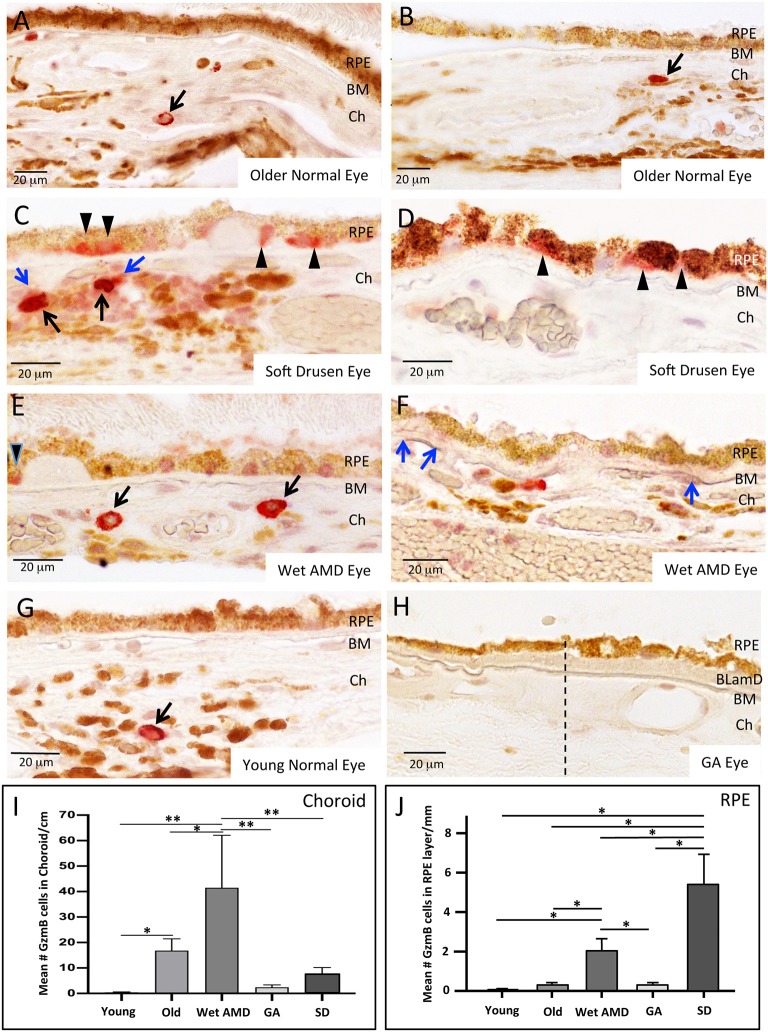
GzmB Immunoreactivity in normal and diseased human outer retina. (A,B) Examples of GzmB immunoreactivity in an older normal eye. Strong labeling with amino-ethyl carbazole chromogen (red) indicates GzmB+ cells in the choroid (black arrows). RPE cells in older normal eyes rarely displayed GzmB immunoreactivity. (C,D) Examples of GzmB immunoreactivity in eyes with soft drusen, an early marker of AMD. Strong labeling with amino-ethyl carbazole chromogen (red) indicates GzmB+ cells in the choroid (black arrows), with a cloud of extracellular GzmB immunolabeling surrounding the choroidal mast cells (blue arrows). The basal compartment of the RPE cell near soft drusen sites also contains GzmB immunoreactivity (black arrowheads). Note GzmB+ RPE appear of the “non-uniform” phenotype (27). (E,F) Examples of GzmB immunoreactivity in a wet AMD eye. Strong labeling with amino-ethyl carbazole chromogen (red) indicates GzmB+ cells in the choroid (black arrows). Extracellular GzmB immunolabeling is evident in the basal laminar deposit (blue arrows) of a wet AMD eye. In wet AMD eyes, fewer RPE cells contained GzmB compared to eyes with soft drusen, however, one is shown in (E) near a drusen site (black arrowhead). (G) An example of GzmB immunoreactivity in a younger normal eye demonstrating a single choroidal mast cell (arrow). RPE cells in younger normal eyes rarely displayed GzmB immunoreactivity. (H) GzmB immunoreactivity in a GA eye. Note lack of red chromogen product in choroid and in RPE. Dash line indicates a change in the morphology of the RPE monolayer, with “non-uniform” and “dissociated” RPE phenotypes to the right of the dashed line (27). Note thickened basal laminar deposit (BLamD) and deterioration of the choriocapillaris. Additional images of a GA eye are shown in Supplementary Figure 6. (I) Analysis of GzmB immunoreactivity of choroidal cells in older (>65 years, N = 8) and younger (<55 years N = 8) normal donor eyes, wet AMD (N = 6), GA (N = 8), and soft drusen eyes (N = 9). The number of GzmB+ choroidal cells was significantly higher in wet AMD eyes compared to all other groups, while the number of GzmB+ choroidal cells in older eyes was significantly higher than younger eyes. One-way ANOVA Test and Tukey's multiple comparisons post-hoc test (*p < 0.05; **p < 0.01). (J) Analysis of GzmB immunoreactivity of RPE cells in older (>65 years, N = 8) and younger (<55 years N = 8) normal donor eyes, wet AMD (N = 6), GA (N = 8), and soft drusen (N=9). The number of GzmB+ RPE cells was significantly higher in soft drusen compared to all other groups, while the number of GzmB+ RPE cells in wet AMD eyes was significantly higher than younger, older and GA eyes, but significantly lower than soft drusen eyes. One-way ANOVA Test and Tukey's multiple comparisons post-hoc test. (*p < 0.05). Scale bar: 20 μm.